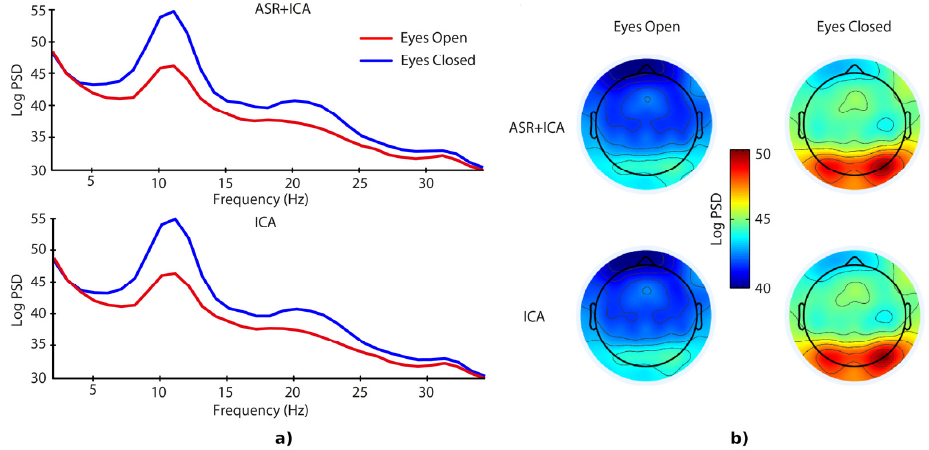
Figure 3. Results of eyes-open/eyes-closed conditions: ( a ) resting-state log10 power spectrum density from channel POz; ( b ) maps of alpha band distribution on the skull (the upper part of the figure presents ASR + ICA and the lower part represents the ICA condition).